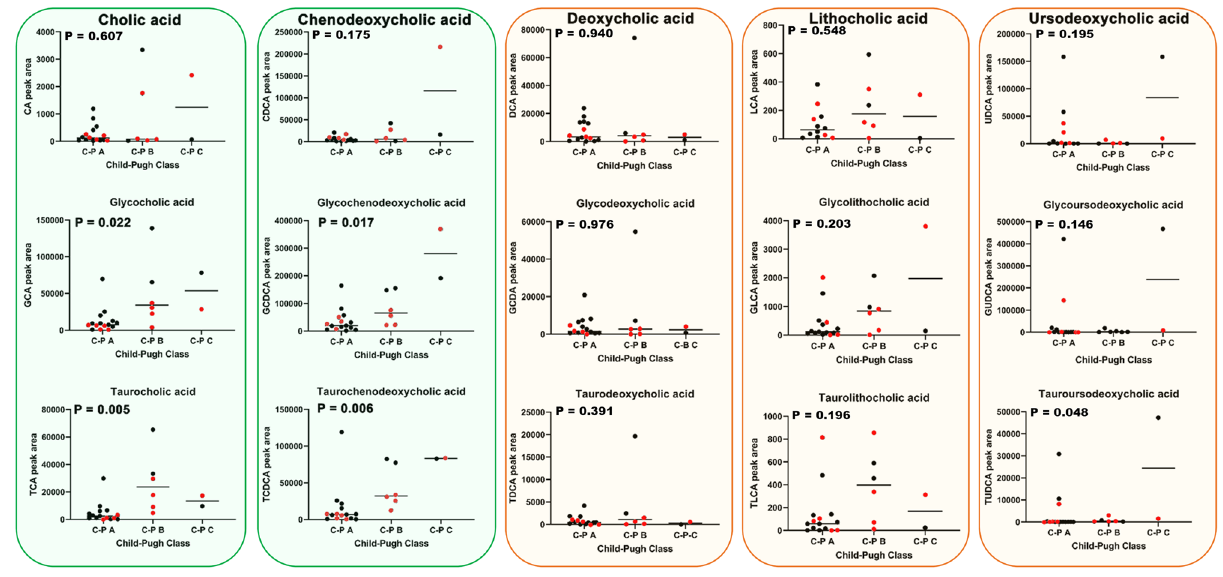
Figure 4. Relationships (Kruskal–Wallis test) between plasma area responses of 15 bile acids and severity of cirrhosis determined by Child–Pugh classes A, B and C. Green boxes represent the primary bile acids cholic acid and chenodeoxycholic acid. Brown boxes represent the secondary bile acids deoxycholic acid, lithocholic acid and ursodeoxycholic acid. Each free bile acid is grouped together with its glycine and taurine conjugates. C-P mean Child–Pugh. Black symbols represent LC patients without HCC and red symbols represent LC patients with HCC. Bile acid LC with HCC LC without HCC P